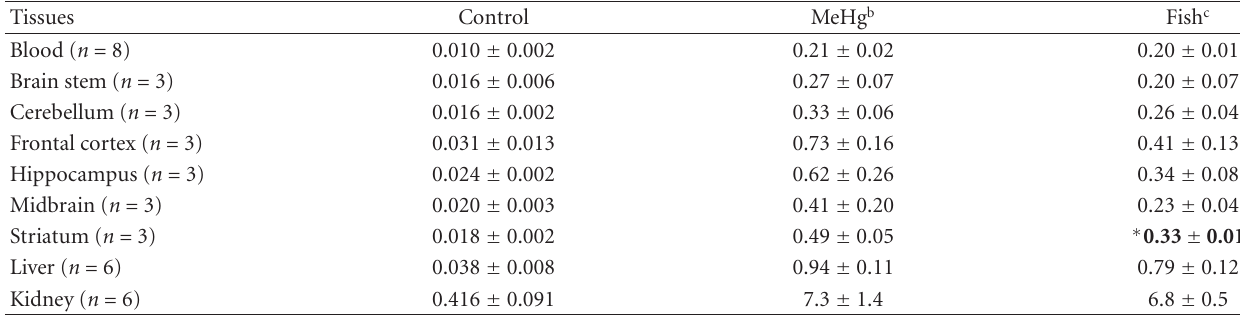
Table 3: Total mercury concentrations in mice tissues a .